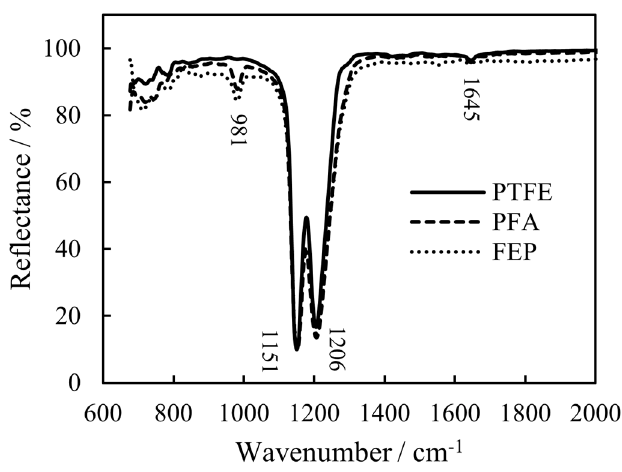
Figure 10. Fourier transform infrared spectra of PTFE, PFA, and FEP coatings.